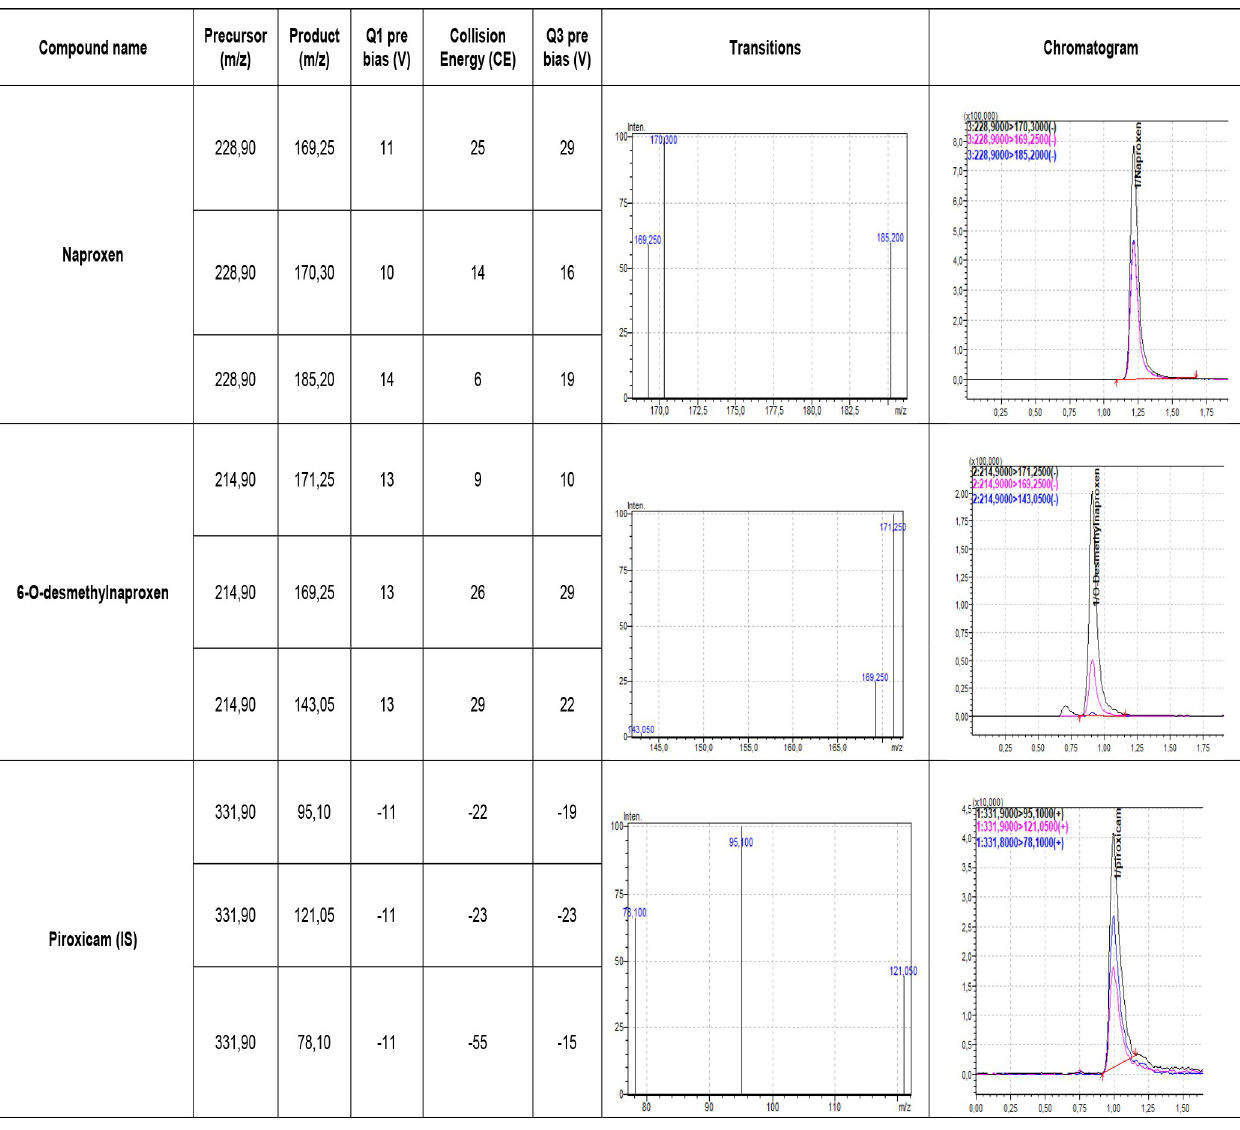
Fig 1. Multiple reaction monitoring mode to quantify the naproxen, 6-O-desmethylnaproxen, and piroxicam transitions.